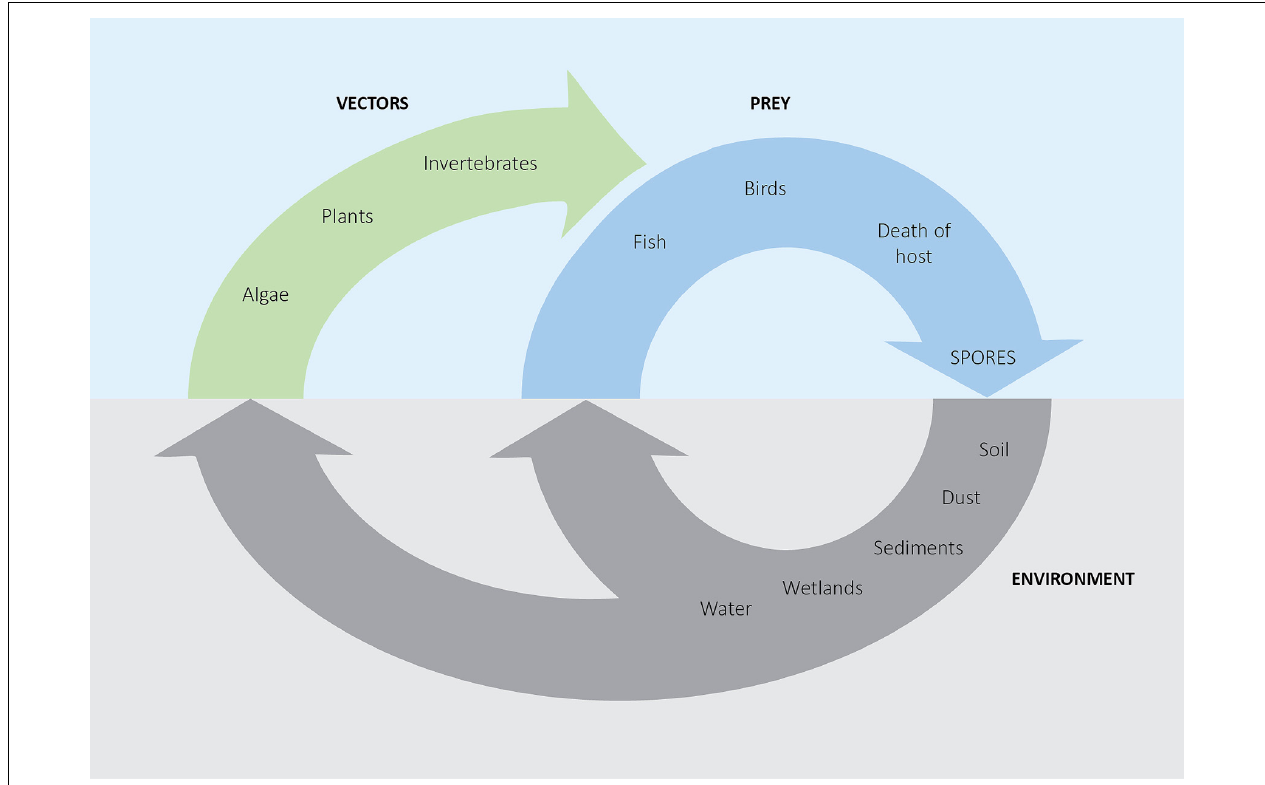
FIGURE 1 | Schematic representation of the role of C. botulinum in a freshwater ecosystem. Resistant spores are released from dead hosts into the abiotic environment, and are spread by air and waterways.The spores may directly infect prey hosts or can be taken up by toxin-unaffected organisms, forming a biotic